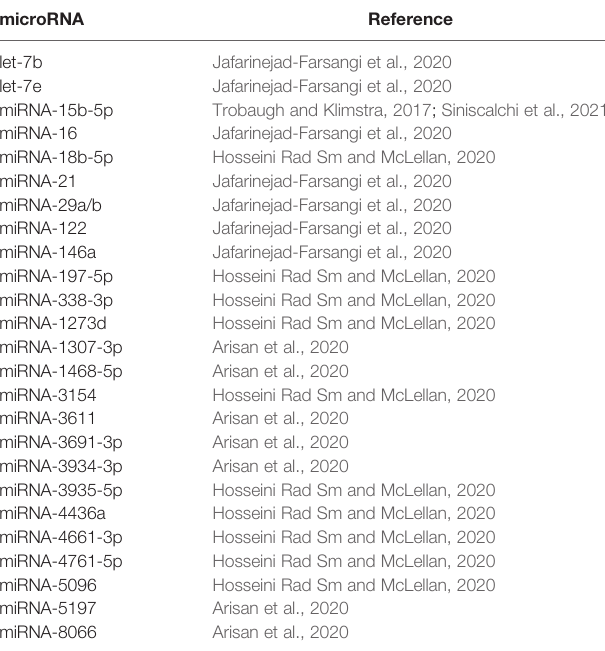
TABLE 1 | miRNAs predicted to interact with the ssvRNA of